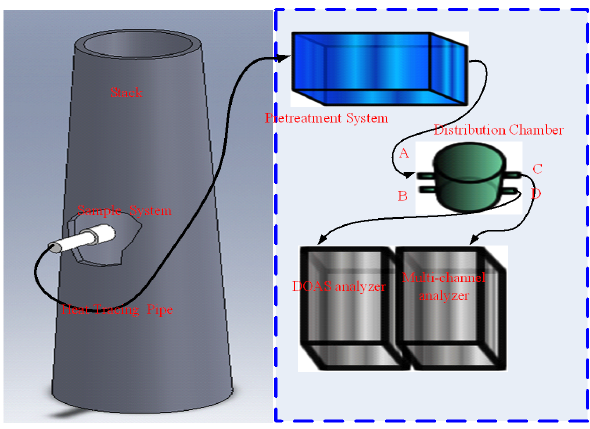
Figure 13. SO 2 concentration series of Fuxin steel plant mea- sured with the DOAS analyzer and the multichannel analyzer on 6 July 2011. Measurements acquired during the blowback period are